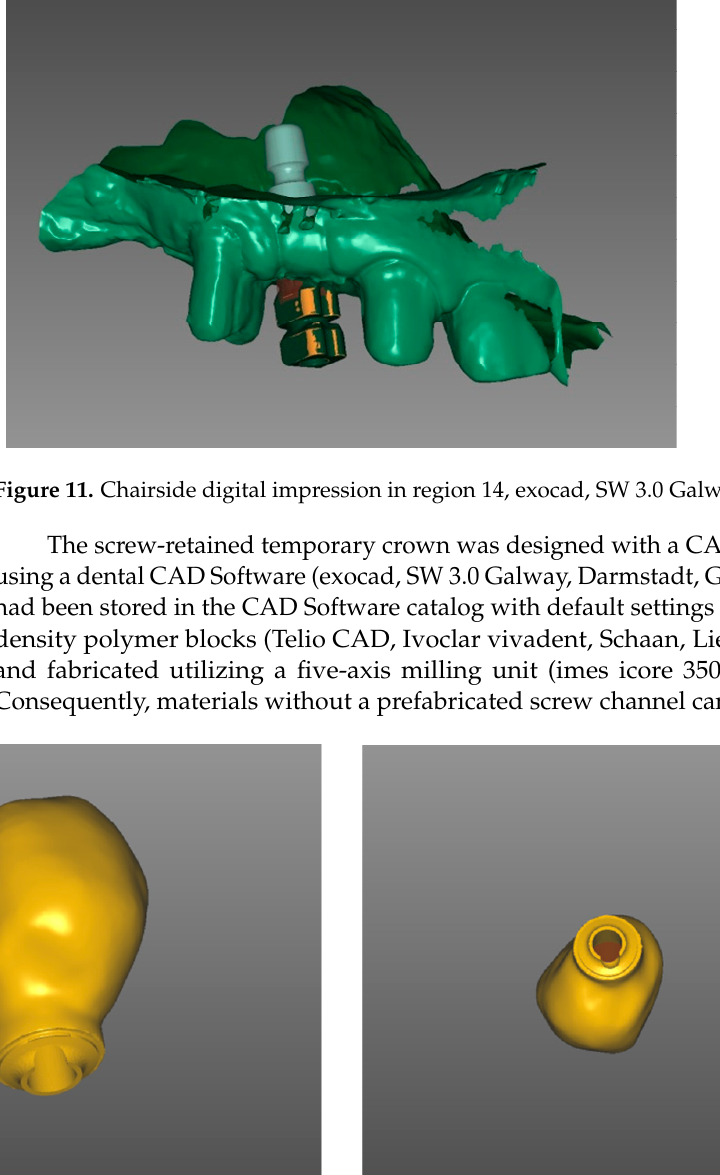
Figure 12. Chairside digital design for implant 14 exocad, SW 3.0 Galway: ( a ) bucco-distal view; ( b ) bucco-inferior view.